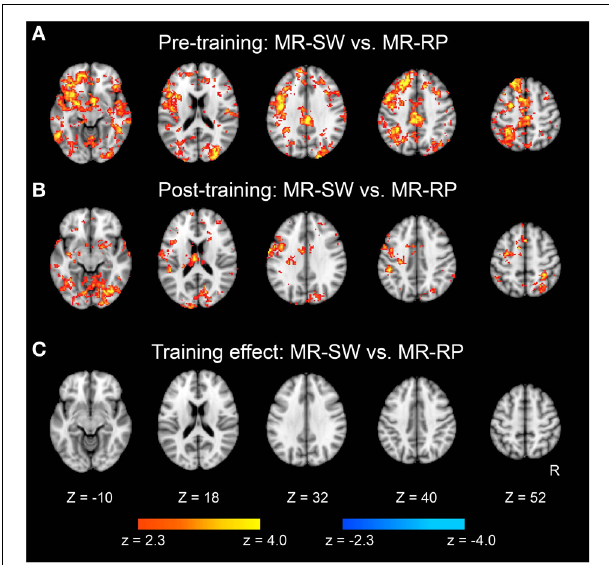
FIGURE 6 | Statistical significance maps for searchlight MVPA for Mirror-Switch vs. Mirror-Repeat trials ( P < 0 . 05 cluster size corrected). (A) Pre-training session. (B) Post-training session. (C) The difference in classification accuracy between pre- and post-training session. The formats are similar to those in Figure 5 .